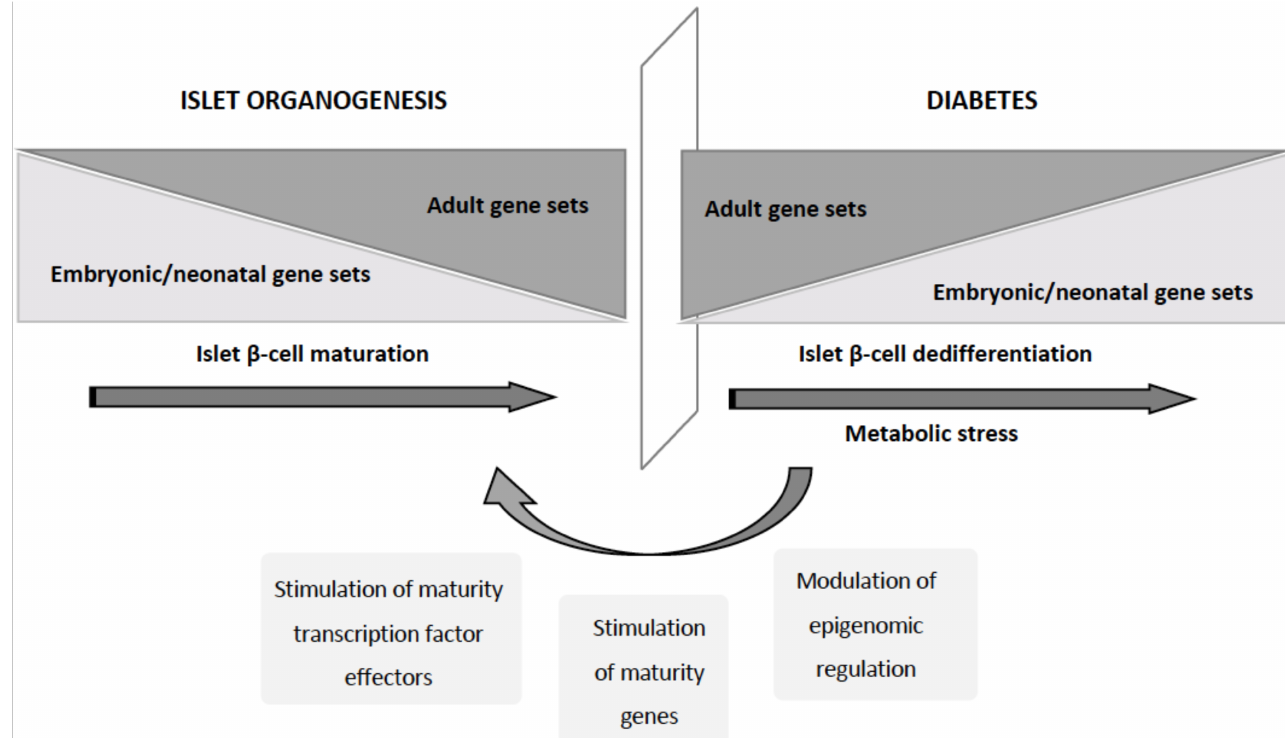
Figure 4. Redifferentiation of islet β -cells. The metabolic stress-induced overload of β -cells triggers their dedifferentiation in an attempt to avoid cell death. This process is due to the reactivation of gene set characteristics of the immature β -cells. Nevertheless, this process can be reversed since the dedifferentiated β -cells retain the potential to be